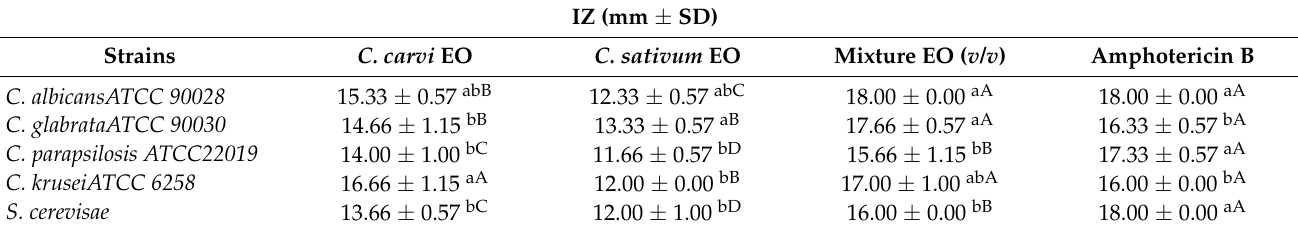
Table 4. Inhibition zones of growth (IZ mm ± SD), showing the qualitative antifungal activity of two EOs ( C. carvi